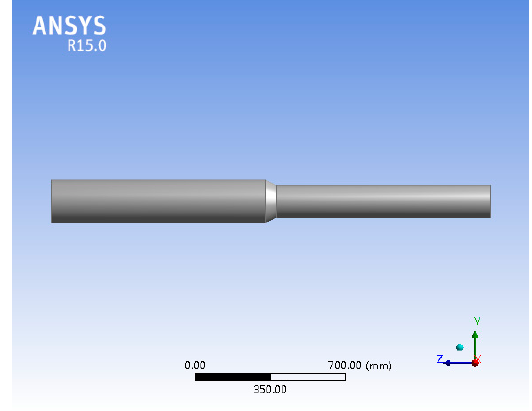
Figure 9. The 3D model diagram of the reducer.